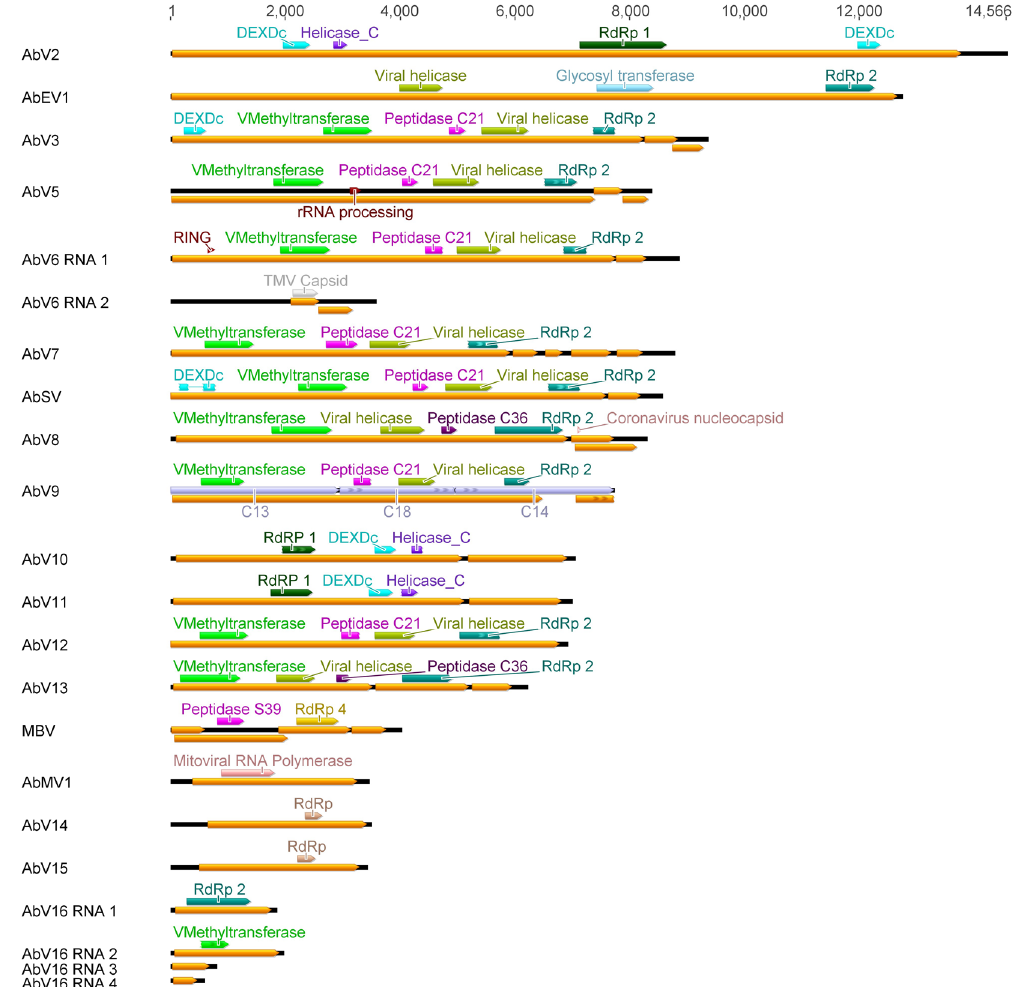
Figure 1. The genome organisation and protein coding potential of the viruses. ORFs greater than 300 bases on the + strand are shown as yellow annotations. Grey annotations indicate assembled contigs. Protein domains identified by NCBI Conserved Domain Search (E-value threshold 0.01) or HHPRED (p < 10–3) are shown as annotations in other colours. Incomplete annotations are shown with a jagged edge. Scale is length in